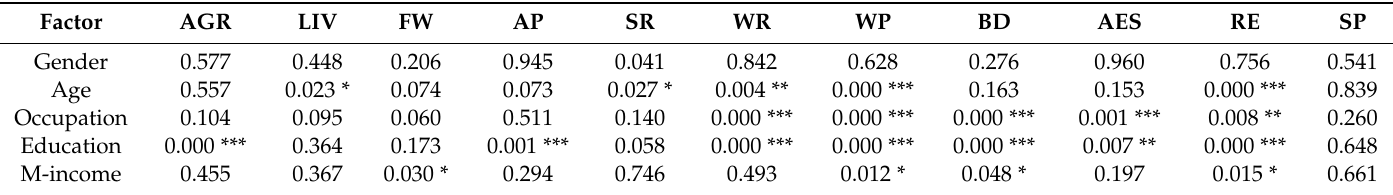
Table 1. p value and significance of variance analysis.